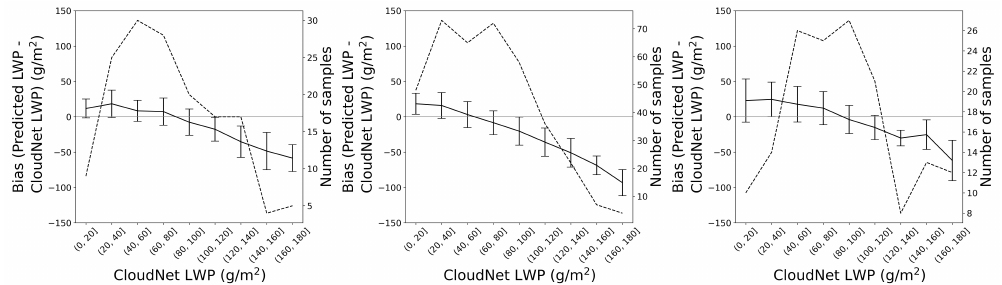
Figure 4. Bias calculated for bins of 20 g m − 2 from daily medians of LWP retrieved by the GBRT model as a function of CloudNet LWP for Leipzig ( left ), Lindenberg ( middle ), and Juelich ( right ) for homogeneous cloud fields without feature selection. The error bars are for one standard deviation of samples in each bin. The dotted line indicates the number of